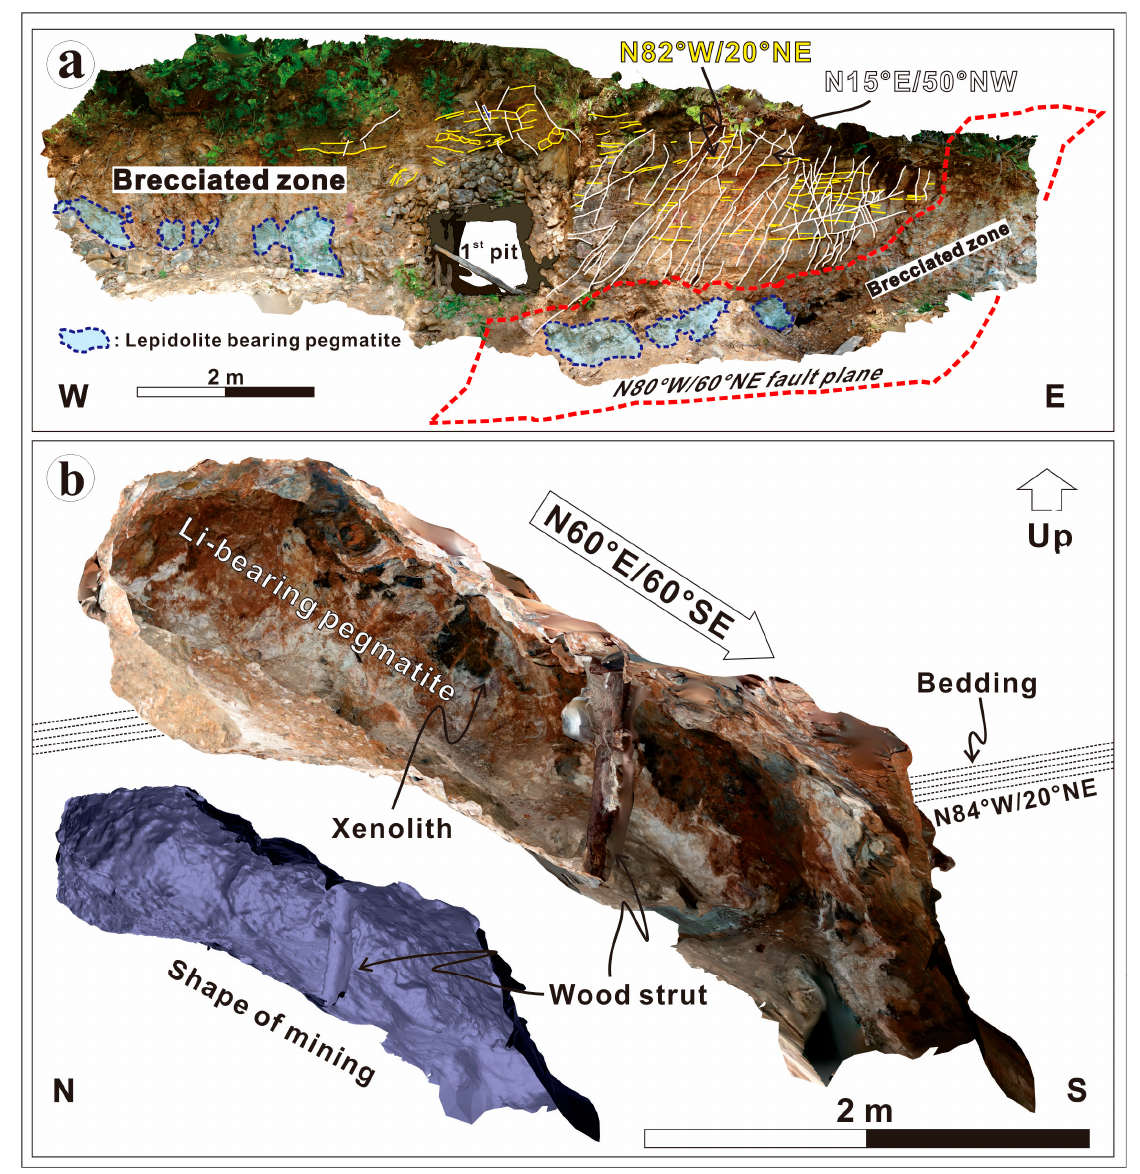
Figure 5. Western slope and rare-element pegmatite (REP) bodies (Pgt 4, pit 1) of the Boam deposit. ( a ) Brecciated host rock and REP body mixed in the N80 ◦ W/60 ◦ NE-striking fault zone and on the slope. White dotted lines indicate fractures. ( b ) Lenticular and N60 ◦ E/60 ◦ SE-striking Pgt 4 in the pit cross-cutting the bedding. The solid image generated using Agi software shows the shape of the